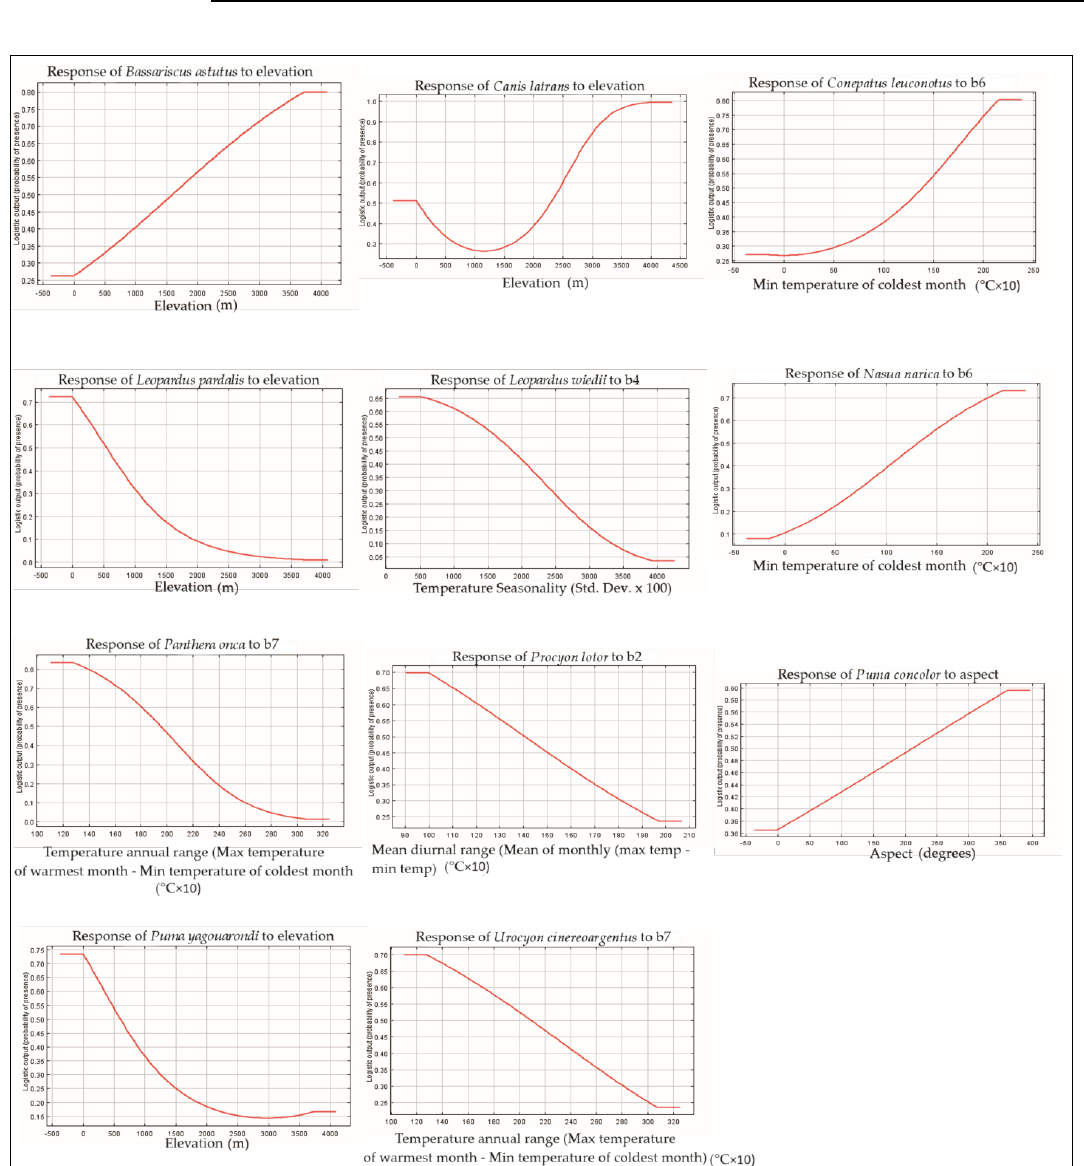
Figure A1. Response curves of the most important prediction variables, when using only the corre- sponding variable for creating a maxent model.